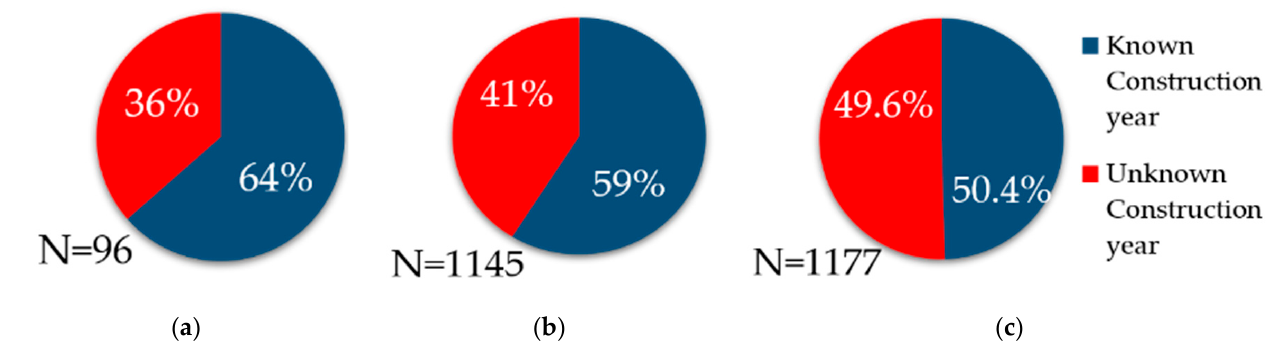
Figure 2. The percentage of bridges with known and unknown year of construction: ( a ) long bridges (length ≥ 100 m), ( b ) medium bridges (20 m ≤ length < 100 m), and ( c ) short bridges (length < 20 m).